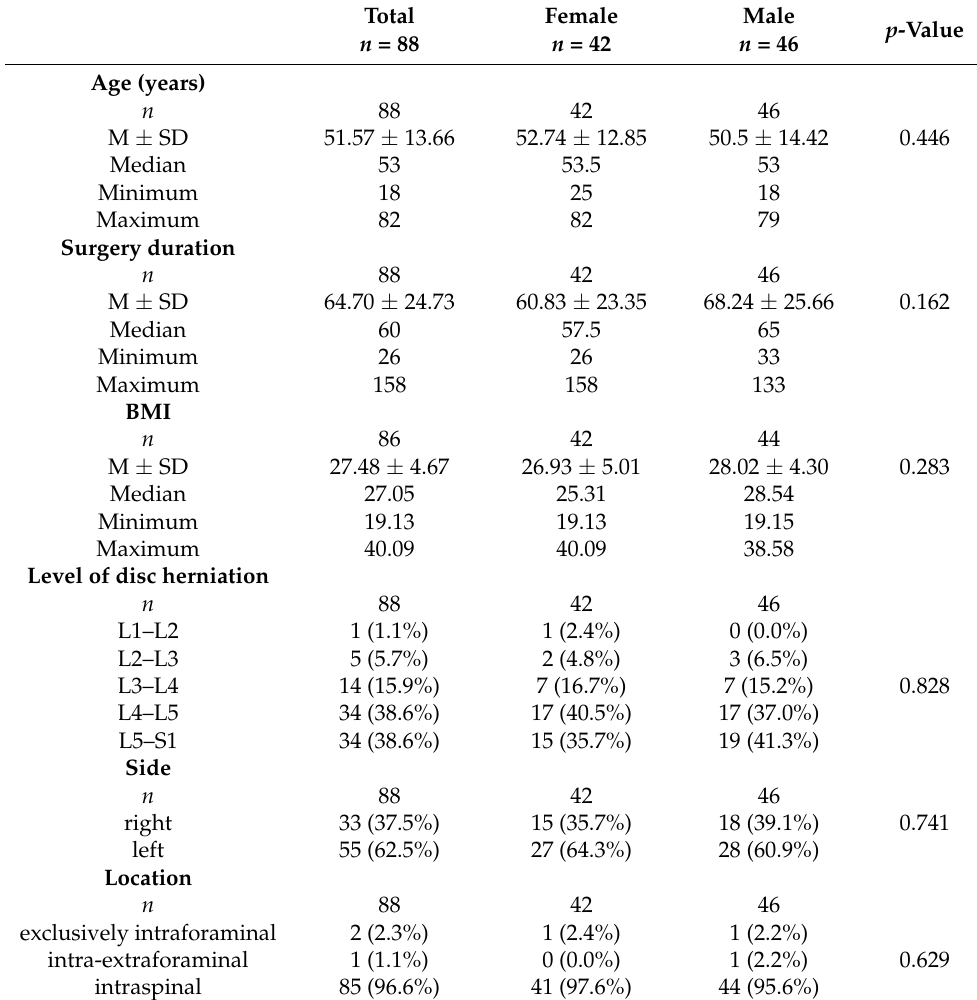
Table 1. Sociodemographics subdivided by